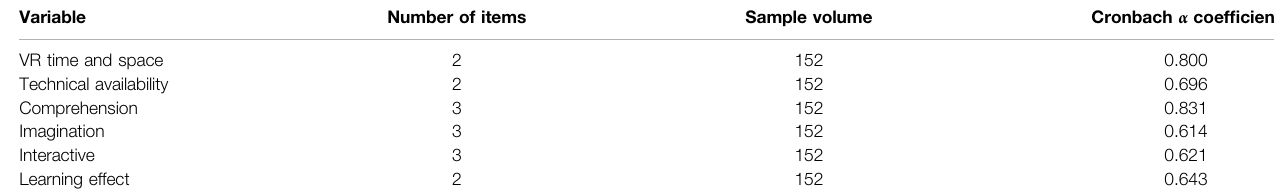
TABLE 2 | Cronbach credit analysis.